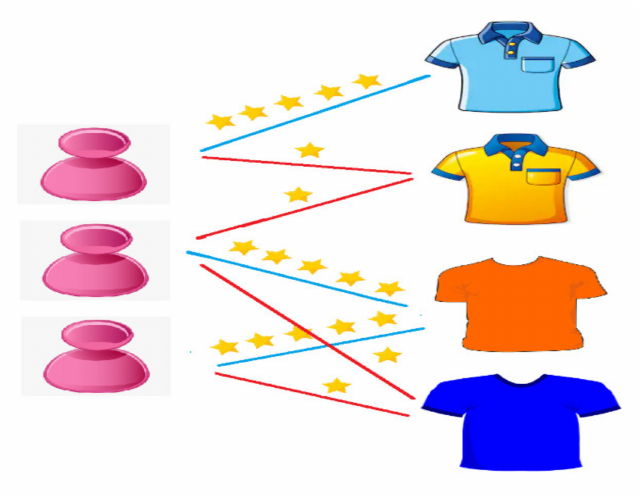
Figure 4. Content-based filtering